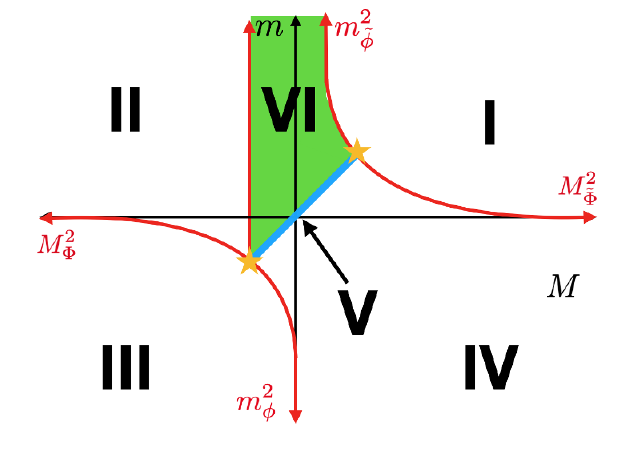
Figure 6 . Phase diagram for (cid:13)avor broken QCD 3 with f < k; F = k . These phases are described in section